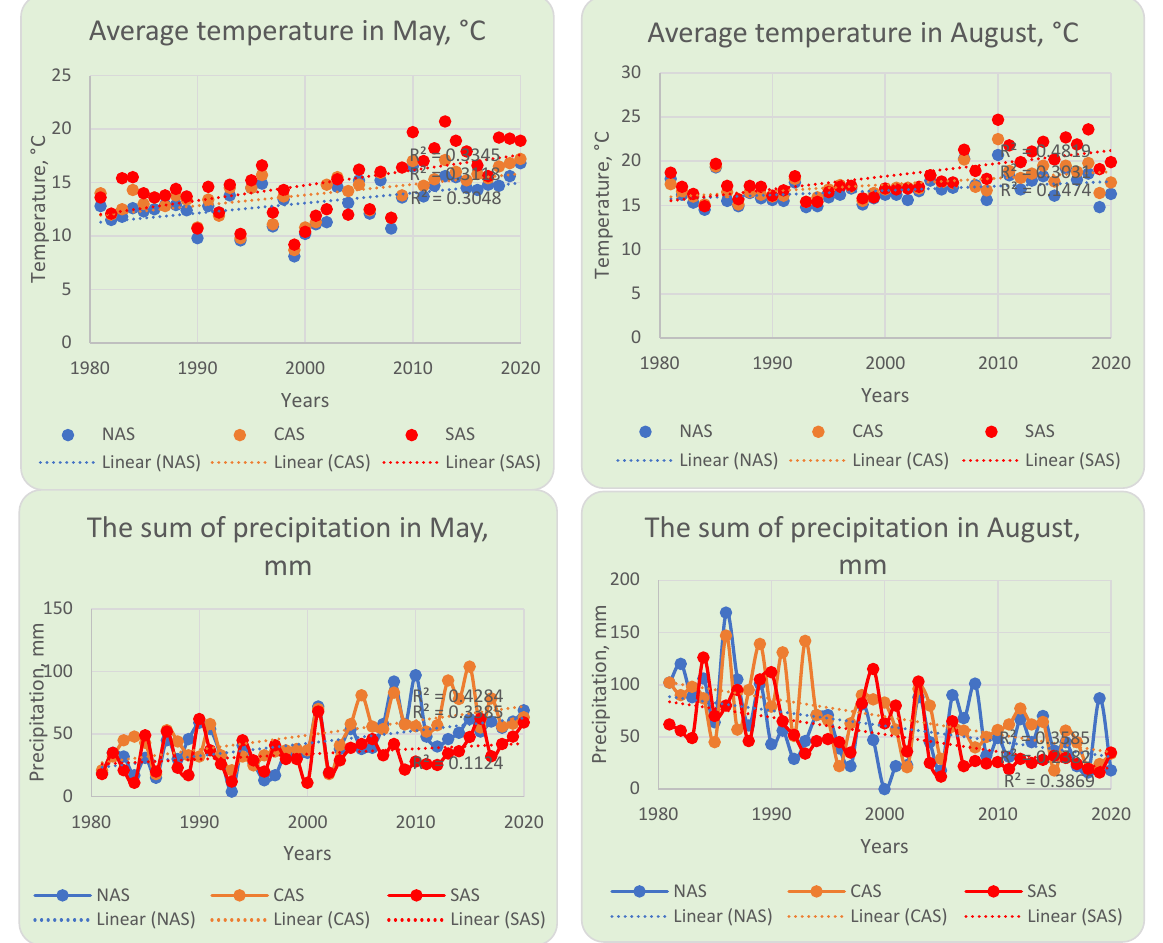
Figure 3. Dynamics of average monthly air temperatures and precipitation in May and August for the period from 1981 to 2020 by agro-climatic subzones in the Central region of the Non-Chernozem zone.